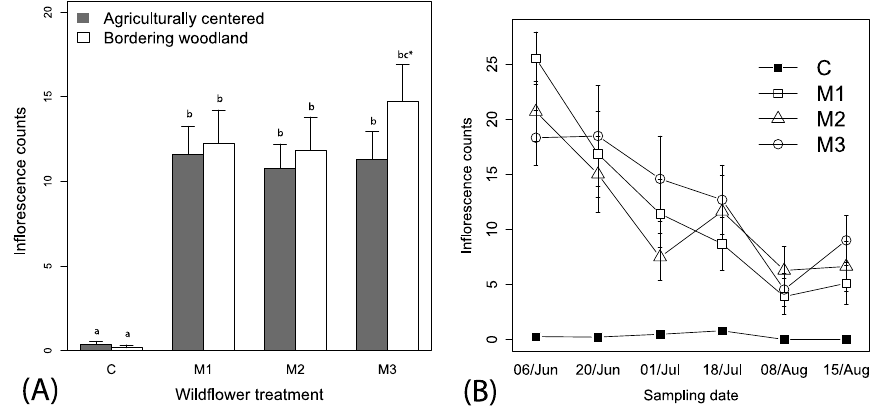
Figure 2. Mean (+1 SE) observations of ( A ) inflorescences among the mixes in relation to local spatial context, and ( B ) across time. Legend labels: C—control, M1—floral mix, M2—floral mix, and M3—floral mix; Table S1). Lowercase letters in panel ( A ) represent adjusted linear comparisons α = 0.05, where all wildflower treatments (M1, M2, M3) were significantly different from the control (C), and there was a tendency for there to be more flowers in plots adjacent to woodlands for M3 (indicated by bc*).